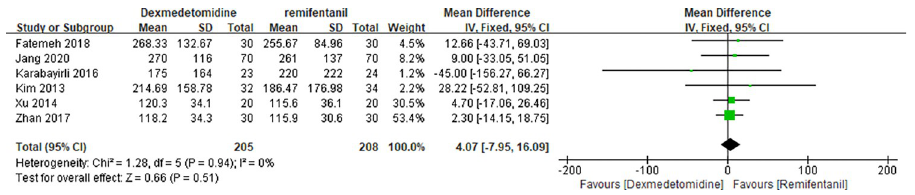
Fig 7. Forest plot of blood loss. Dexmedetomidine group vs. remifentanil group.